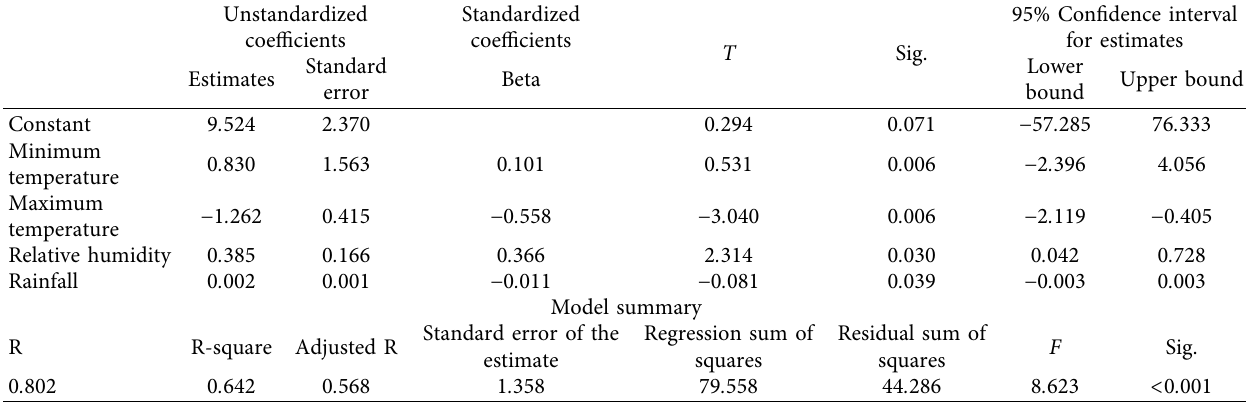
Table 4: Multiple linear regression output of yam yield under climatic